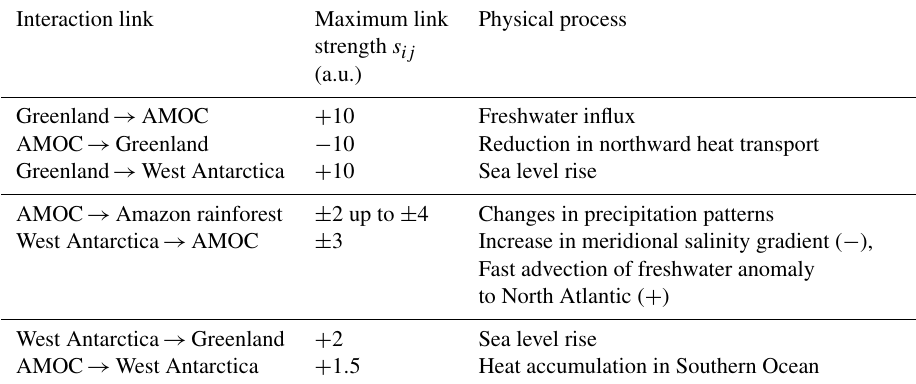
Table 2. Interaction links in the network of tipping elements. For each link in the network of Fig. 1, there is a strength and a sign for each interaction of the tipping elements. The sign indicates if the interaction between the tipping elements is increasing or decreasing the danger of tipping cascades. Following Kriegler et al. (2009), the strength s ij gives an estimate in terms of increased or decreased probability of cascading transitions (Kriegler et al., 2009). For example, if Greenland transgresses its threshold, the probability that the AMOC does as well is increased by a factor of 10 (see entry for Greenland → AMOC). A random number between + 1 and s Greenland → AMOC = + 10 is then drawn for our simulations and used for s ij in Eq. (3). Conversely, the probability that Greenland transgresses its threshold if the AMOC . A random number between − 1 and s AMOC → Greenland = − 10 is then drawn. The is in the transitioned state is decreased by a factor of 1 10 main physical processes that connect pairs of tipping elements are described in this table and in Sect. 2.2. The link strengths are grouped into strong, intermediate and weak links. Note that in the expert elicitation (Kriegler et al., 2009), there has been an estimation of the maximum increase or decrease in the tipping probability in the case that the element that starts the interaction is already in the transitioned state. For example, the link between Greenland and AMOC is given as [1; 10] in Kriegler et al. (2009) and is modelled here as a randomly drawn variable between 1 and 10 for s ij . An example of an unclear coupling would be the link between West Antarctica and the AMOC which is given as [0.3; 3] in Kriegler et al. (2009) and we translate into an s ij between − 3 and 3. In general, the values are drawn between 1 and the respective maximum value s ij if the interaction between i and j is positive or between − 1 and the negative maximum value s ij if the interaction between i and j is